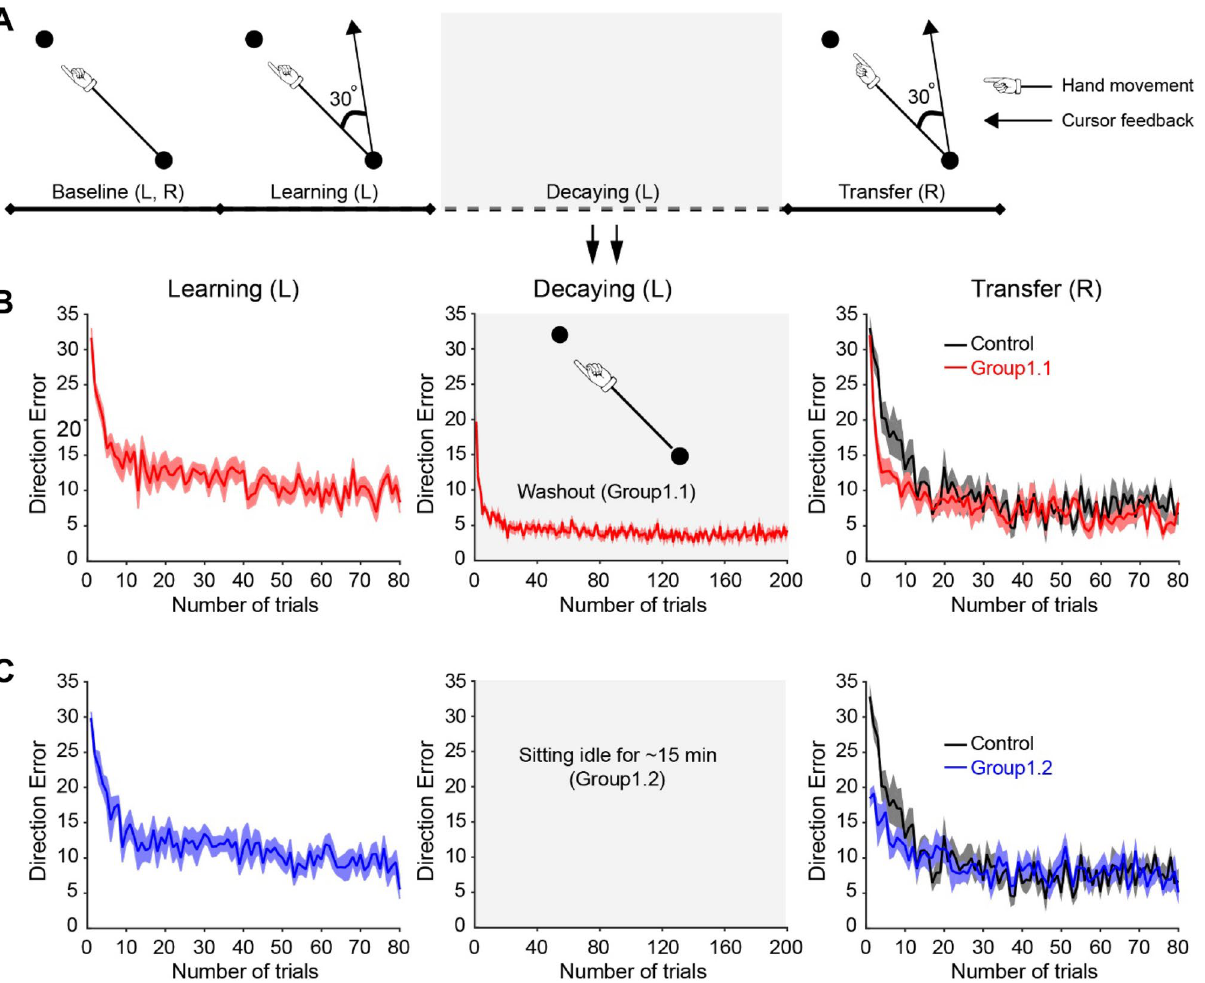
Figure 1. Protocols and the motor performance for Experiment 1. ( A ) The experimental protocol consisted of four sessions: baseline (veridical feedback), learning (30° CCW rotation), decaying, and transfer (30° CCW rotation with the opposite arm). The cursor feedback was CCW rotated by 30° from the hand-path in the learning and transfer sessions. ( B ) Mean time-course of the movement errors of the learning, decaying, and transfer sessions were plotted in red lines across trials for Group1.1. Standard errors were represented as the shaded area plot. Veridical cursor feedback was provided during the decaying session as shown in the mid panel. The control group’s right arm performance in the transfer session was plotted as black line in the right panel for comparison. ( C ) Mean time-course of the movement errors for Group1.2 in blue lines. The subjects sit idle during the decaying session (mid panel). The control group’s right arm performance was plotted in black in the right panel for